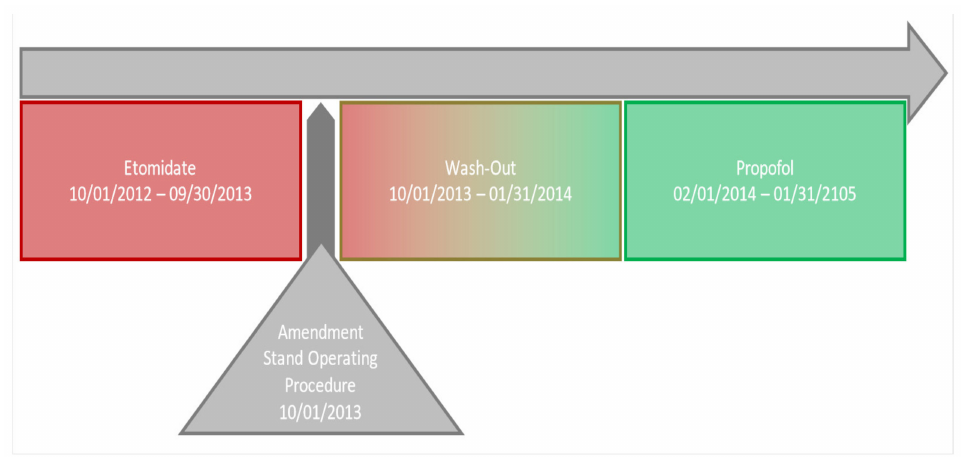
Figure 1. Study design. A detailed visual description of the different study